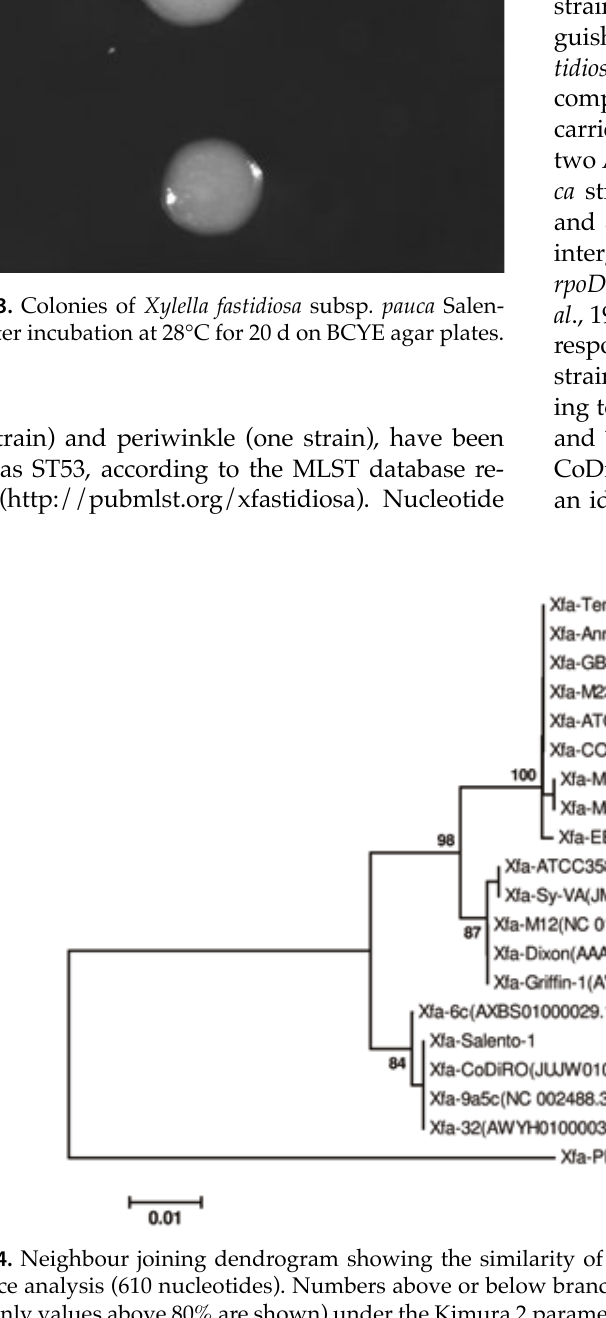
Figure 4. Neighbour joining dendrogram showing the similarity of 20 strains of Xylella fastidiosa based on dnaA partial sequence analysis (610 nucleotides). Numbers above or below branches are bootstrap values based on 1000 pseudorepli- cates (only values above 80% are shown) under the Kimura 2 parameters model of evolution with gamma rate of variation across sites. The accession numbers of the reference strains genomes are given in